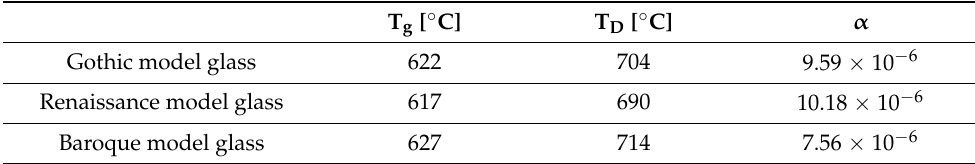
Figure 9. Thermal expansion curves of model glasses. The glass transformation temperature T g and deformation temperature (T D ) of model glasses are given in Table 6 together with the calculated dilatation coefficient α . Table 6. Thermal expansion data for model glasses. T g [°C]